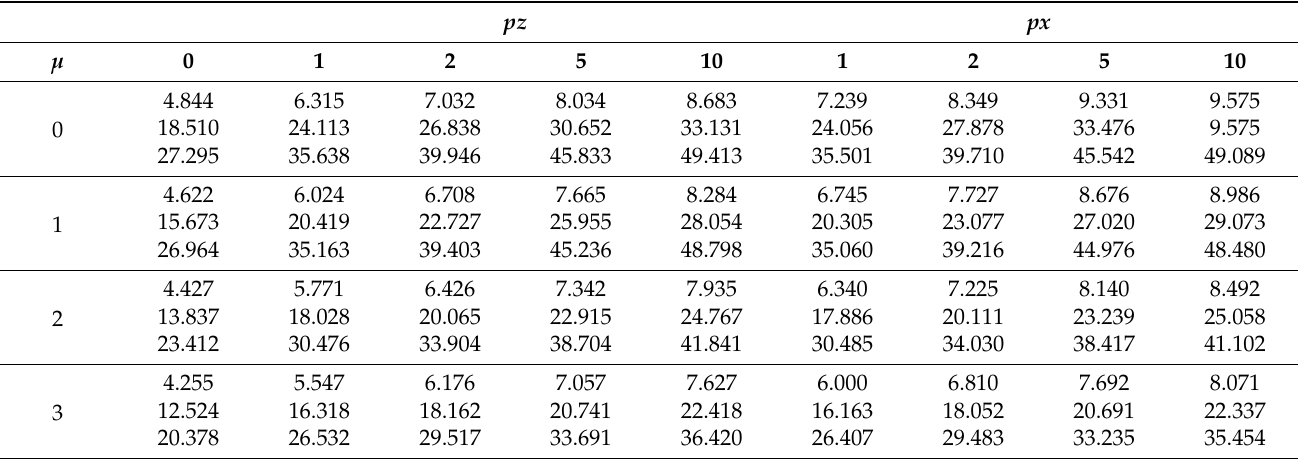
Table 7. Nondimensional first three natural frequencies ( Ω adim ) of SS FGM2-Z and FGM2-X beams, using aluminium as reference. L/h = 10.